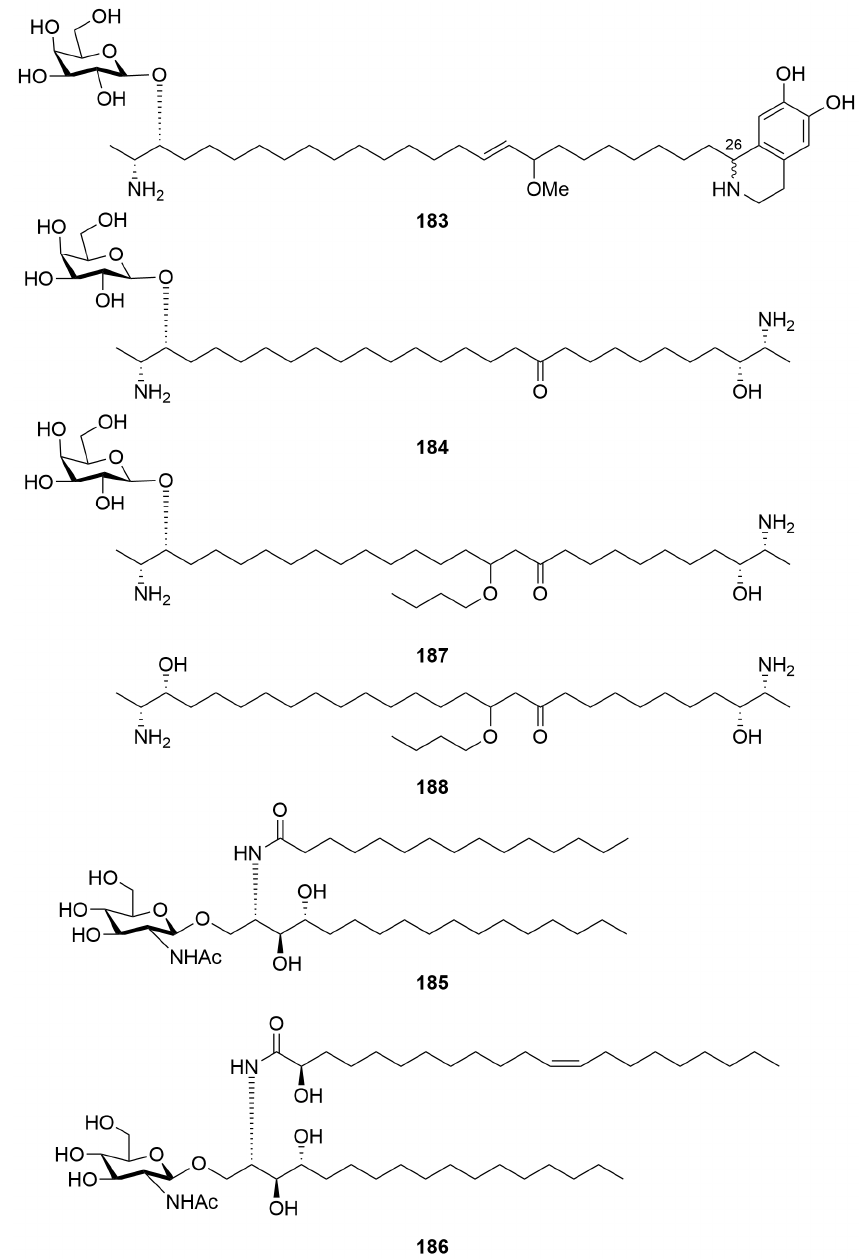
Figure 12. Compounds 183 to 188 .